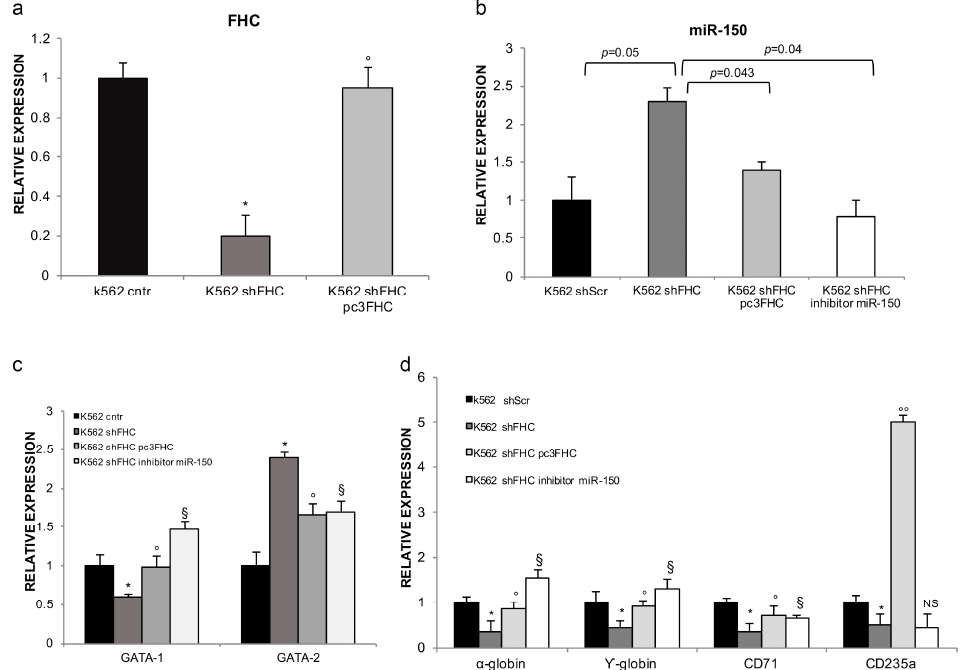
Figure 5. miR-150 mediates the control exerted by FHC on GATAs , α -globin , γ -globin and CD71 expression. ( a ) pc 3 FHC expression vector almost completely restore FHC amounts in FHC-silenced K562 cells (K562 shFHC/pc3FHC ). Data represent mean ± SD of 3 qRT-PCR analysis. * p < 0.05 compared with K562 shScr ; ◦ p < 0.05 compared with K562 shFHC ; ( b ) TaqMan analysis of miR-150 levels after FHC reconstitution and miR-150 inhibition highlight a significant down-regulation in K562 shFHC/pc3FHC and K562 shFHC/miR − 150 inhibitor compared to K562 shFHC cells; ( c ) qRT-PCR analysis of GATA-1 and GATA-2 genes in K562 shFHC/pc3FHC and K562 shFHC/miR − 150 inhibitor as compared to K562 shFHC cells. Data represent mean ± SD ( n = 3). * p < 0.05 compared with K562 shScr at; ◦ p < 0.05 compared with K562 shFHC ; § p < 0.05 compared with K562 shFHC ; ( d ) qRT-PCR analysis of α -globin , γ -globin , CD71 and CD235a genes in K562 shFHC/pc3FHC and K562 shFHC/miR − 150 inhibitor compared to K562 shFHC cells. Data represent mean ± SD ( n = 3). * p < 0.05 compared with K562 shScr at; ◦ p < 0.05 when compared with K562 shFHC ; ◦◦ p < 0.001 compared with K562 shFHC ; § p < 0.05 compared with K562 shFHC ; N.S. not